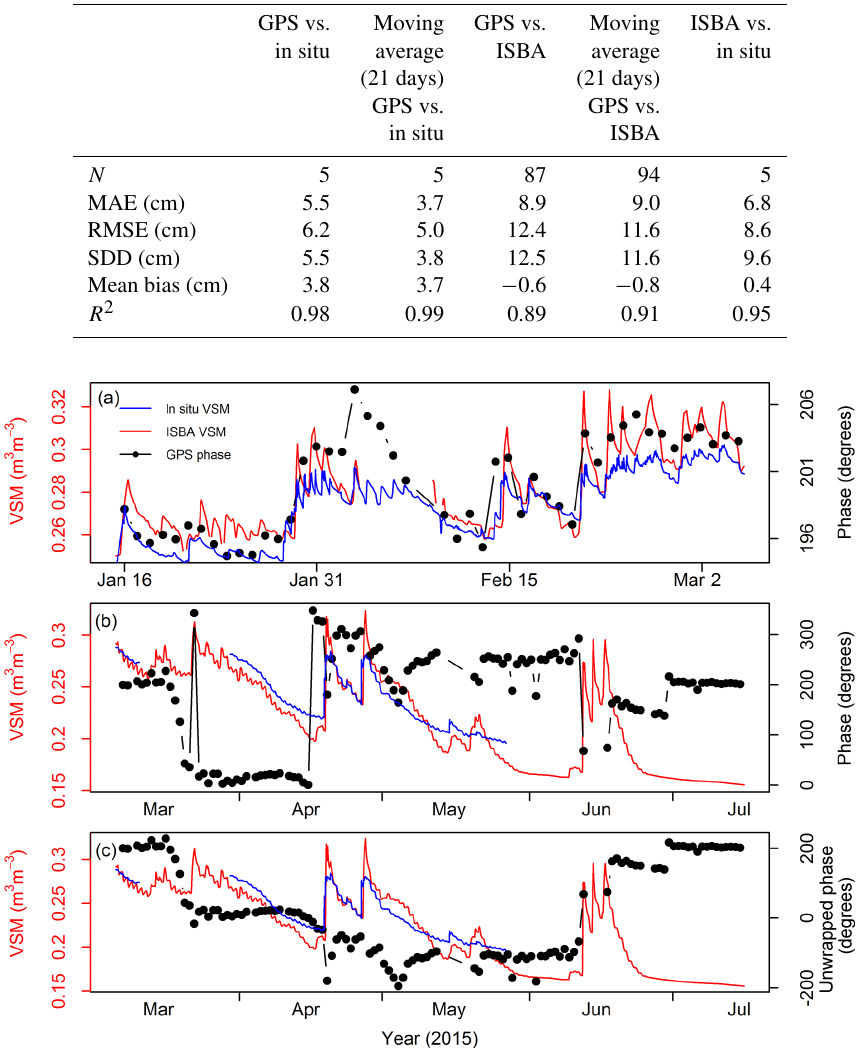
Figure 8. Example of a track data set (descending tracks from GPS10): (a) from 16 January to 5 March, with no significant vegetation effects and (b, c) from 6 March to 15 July, with significant vegetation effects. In (a, b) , multipath phases (black dots) are compared with in situ VSM measurements at 5cm (blue line) and ISBA simulations (red line). In (c) , unwrapped multipath phases (black dots) are used to compare with in situ and simulated